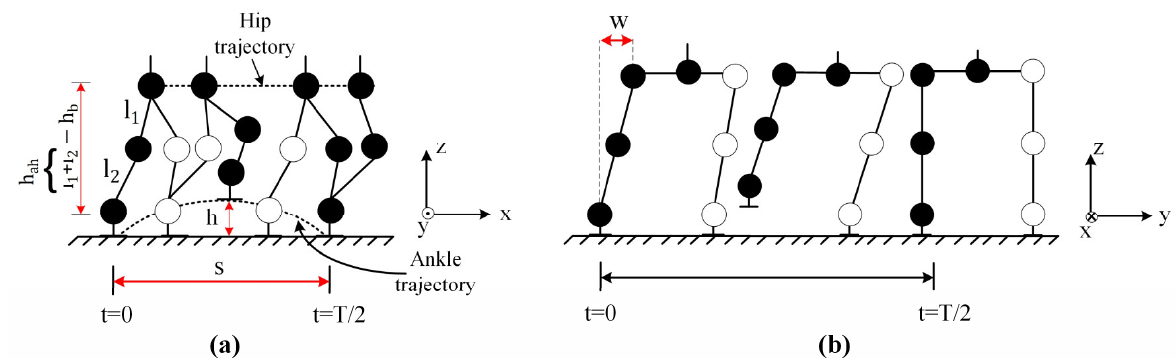
Figure 4. Walking parameters for half gait cycle: ( a ) sagittal plane, ( b ) frontal plane.